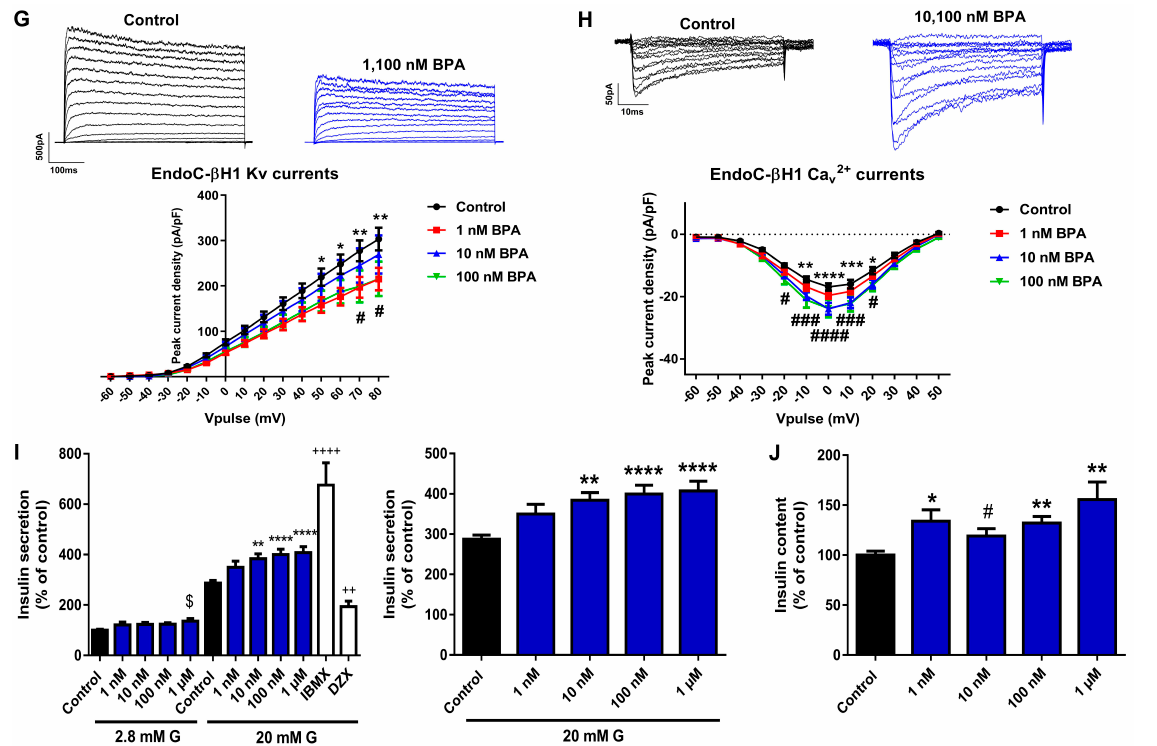
Figure 1. BPA effects on pancreatic β -cells . ( A ) Viability of MIN6 cells treated for 24 h with different BPA concentrations (100 pM–10 µ M) as evaluated by RZ, NRU and CFDA-AM assays. n = five independent experiments. * vs. Control; one-way ANOVA or Kruskal-Wallis. ( B ) mRNA expression of Ins , Pdx1 , Hnf4 α , MafA , Kir6.2 , Sur1 , Glut2, and Gck in MIN6 cells treated for 24 h with different BPA concentrations (100 pM–10 µ M). n = three independent experiments. * vs. Control; one-way ANOVA or Kruskal-Wallis. # vs. Control; Student’s t -test. ( C ) Effects of BPA (100 pM–10 µ M) on GSIS in MIN6 cells treated for 24 h. n = six independent experiments. * vs. Control 16.7 mM G; two-way ANOVA. $ vs. Control 1.67 mM G and + vs. Control 16.7 mM G; Kruskal-Wallis. ( D ) MIN6 insulin content after 24 h BPA treatment. n = six independent experiments. * vs. Control; Kruskal-Wallis. # vs. Control; Student’s t -test. ( E ) Viability of EndoC- β H1 cells treated for 72 h with different BPA concentrations (1 nM–1 µ M) as evaluated by RZ, NRU and CFDA-AM assays. n = four independent experiments. * vs. Control; one-way ANOVA or Kruskal-Wallis. ( F ) mRNA expression of INS , PDX1 , HNF4 α , MAFA , MAFB , KIR6.2 , SUR1 , SNAP25 , GLUT1, and GCK in EndoC- β H1 cells treated for 72 h with different BPA concentrations (1 nM–100 nM). n = three independent experiments. * vs. Control; Kruskal-Wallis. ( G ) Upper panel, representative recordings of K + currents in response to depolarizing voltage pulses in Control or BPA (1 nM–100 nM) EndoC- β H1 treated-cells for 72 h. Lower panel, relationship between K + current density and the voltage of the pulses. Control ( n = 12) and BPA ( n = 12 per condition) cells. * Control vs. 1 nM BPA and # Control vs. 100 nM BPA; two-way ANOVA. ( H ) Upper panel, representative recordings of Ca 2+ currents in response to depolarizing voltage pulses in Control or BPA (1 nM–100 nM) EndoC- β H1 treated-cells for 72 h. Lower panel, relationship between Ca 2+ current density and the voltage of the pulses. Control ( n = 11) and BPA ( n = 10 per condition) cells. * Control vs. 10 nM BPA and # Control vs. 100 nM BPA; two-way ANOVA. ( I ) Effects of BPA (1 nM–1 µ M) on GSIS in EndoC- β H1 cells treated for 72 h. Left panel: GSIS in response to low glucose (2.8 mM G) and high glucose (20 mM G). Right panel is an inset graph that shows insulin release in response to 20 mM G. n = five independent experiments. * vs. Control 20 mM G; two-way ANOVA. $ vs. Control 2.8 mM G and + vs. Control 20 mM G; one-way ANOVA. ( J ) EndoC- β H1 insulin content after 72 h BPA treatment. n = five independent experiments. * vs. Control; one-way ANOVA. # vs. Control; Student’s t -test. All data are expressed as mean ± SEM. Significance * p < 0.05, ** p < 0.01, *** p < 0.001, and **** p < 0.0001; # p < 0.05, ### p < 0.001, and #### p < 0.0001; $ p < 0.05, and $$ p < 0.01; + p < 0.05, ++ p < 0.01, and ++++ p <